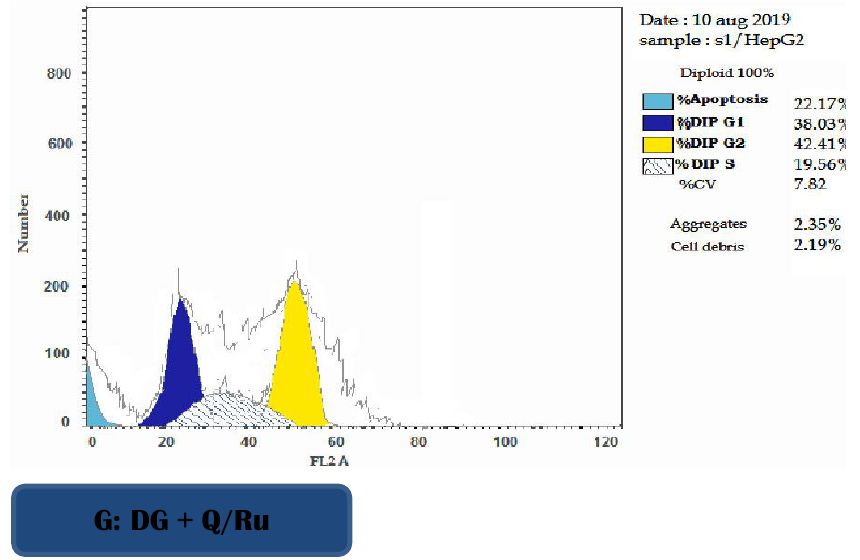
Figure 7. Representative flow cytometric histogram of cell cycle phases in HepG2 cells.